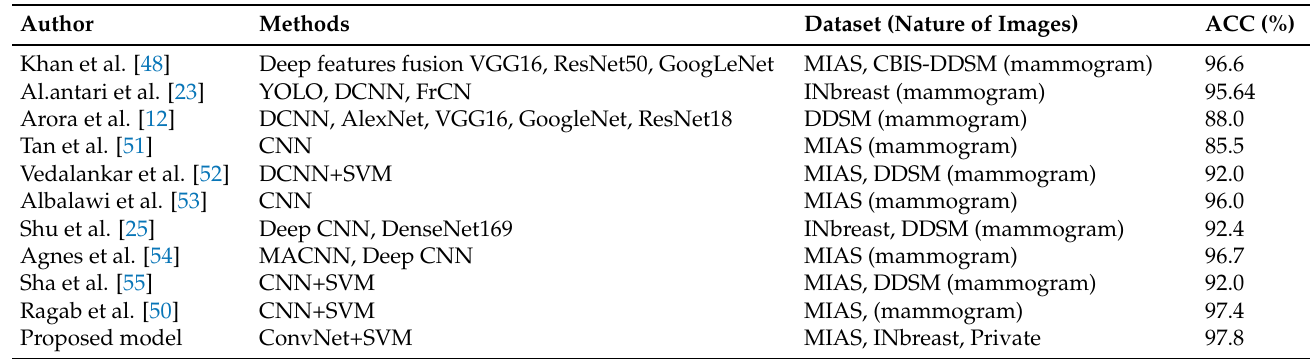
Table 5. Performance comparison with existing